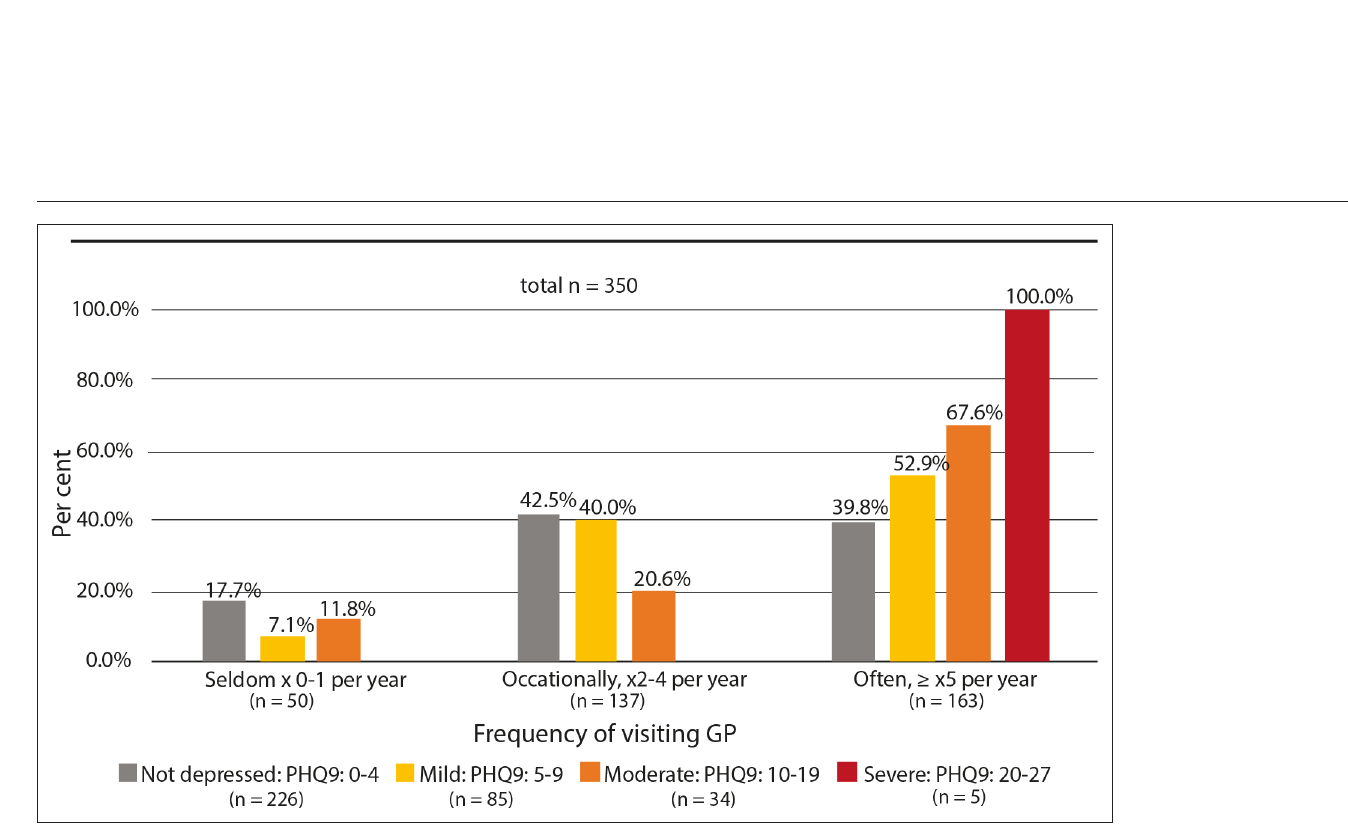
Figure 3 Percentage frequency of consultations, grouped by Patient Health Questionnaire- 9